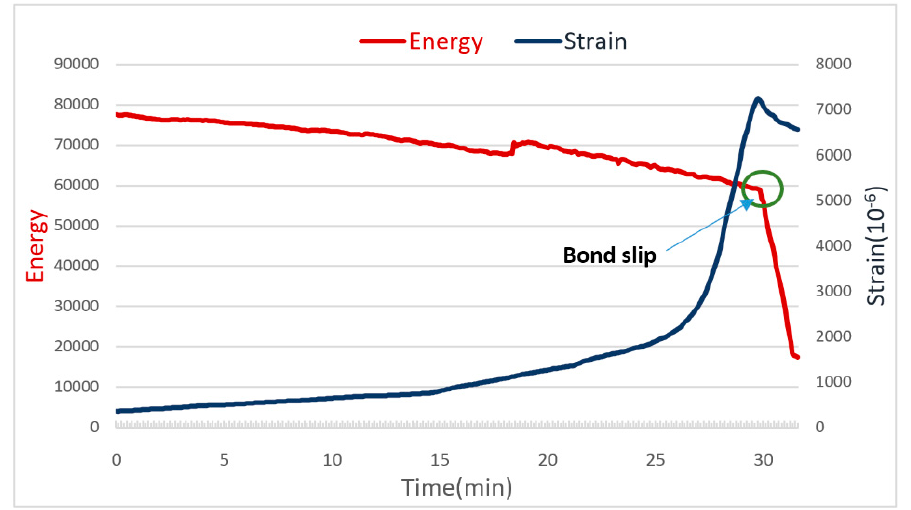
Figure 9. The energy and strain curves of the 4D specimen (experiment 2). Sensors 2018 , 18 , x FOR PEER REVIEW